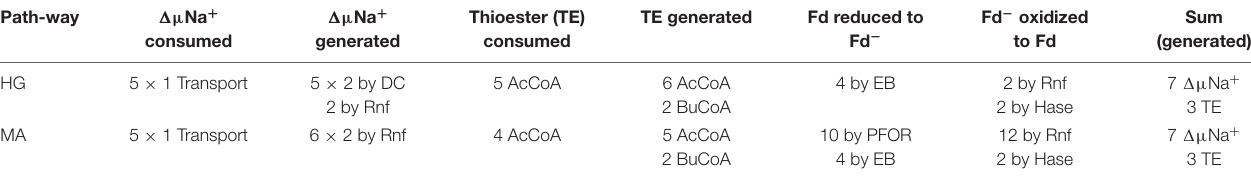
TABLE 1 | Energy conservation in the two pathways of glutamate fermentation. Path-way